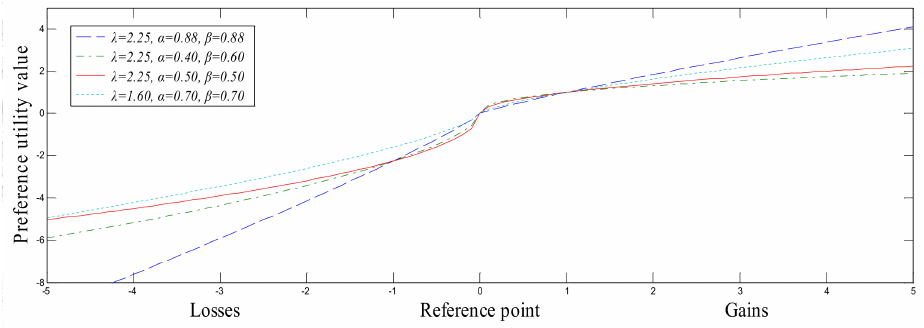
Figure 1. The cumulative prospect theory value